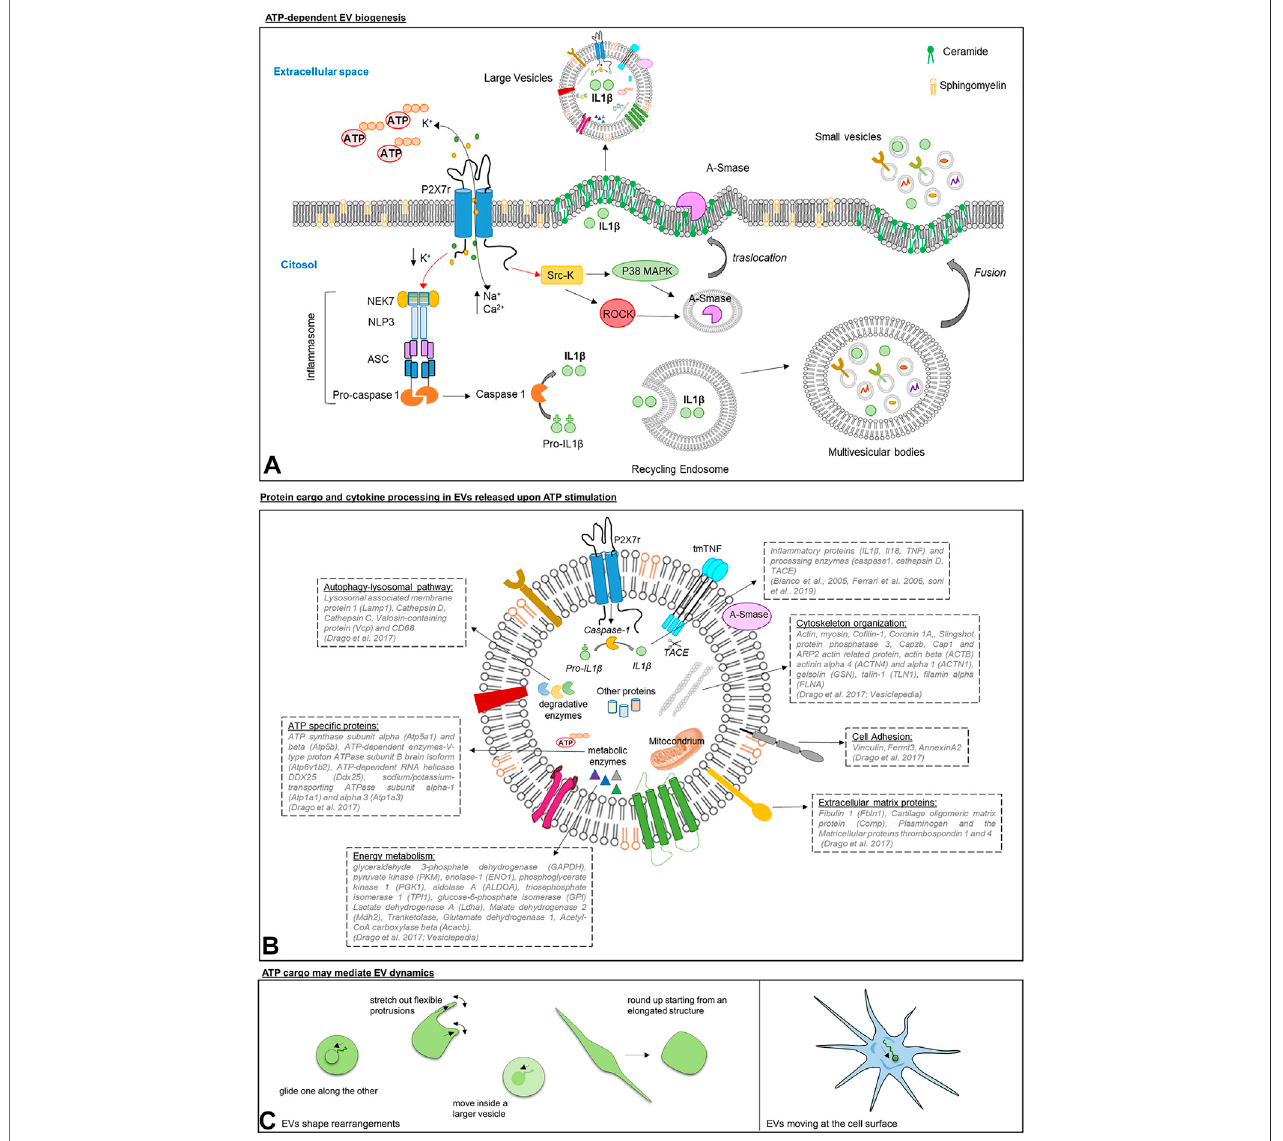
FIGURE 1 | Panel (A) : Scheme of ATP/P2X7R signaling axis inducing EV shedding from immune cells. Upon ATP stimulation, P2X7R activates p 38 MAPK and ROCK through Src kinases. In turn, p 38 and ROCK trigger the local disassembly of the cytoskeletal elements and the mobilization of A-SMASE from the luminal lysosomal compartment to the outer lea fl et of the PM, where the enzyme hydrolyzes sphingomyelin to ceramide favoring blebs formation and the shedding of large vesicles carrying IL-1 β (Bianco et al., 2005).P2X7R also regulates the release of small EVs. ATP-induced P2X7R stimulation drives the assembly and the activation ofthein fl ammasomecomposedbyregulatoryproteins,NEK7,ASCandNLRP3,whichareessentialforcaspase-1activation.Caspase1isaproteaseimplicatedinIL-1 β 2009). Panel (B) : Schematic representation of protein cargo and cytokine processing in large EVs released upon ATP stimulation. By activating P2X7R, ATP induces in large EVs the processing of in fl ammatory cytokines (Hide et al., 2000; Bianco et al., 2005; Ferrari et al., 2006) and sorting of proteins implicated in autophagy-lysosomal